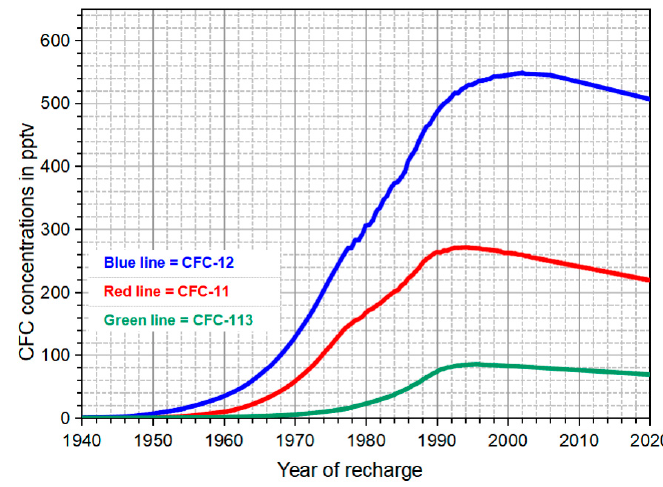
Figure 3. Freon dating curve.